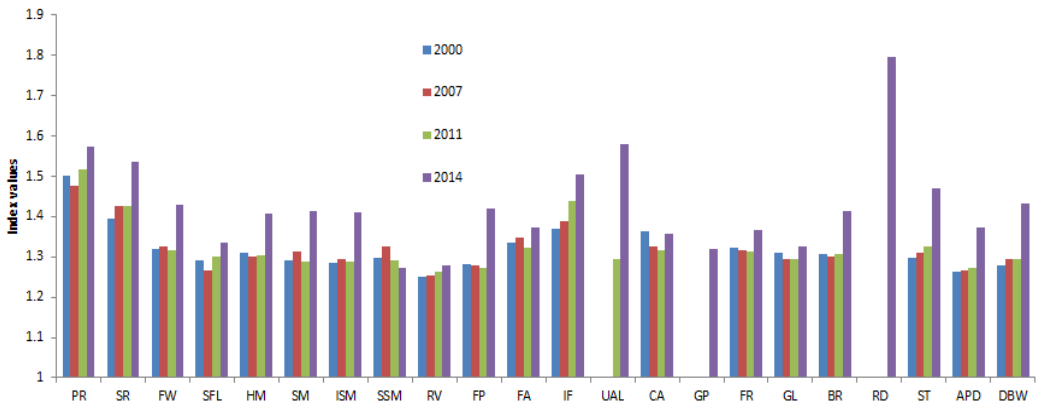
Figure 7. Mean patch fractal dimensions of landscapes in the HRB from 2000 to 2014.